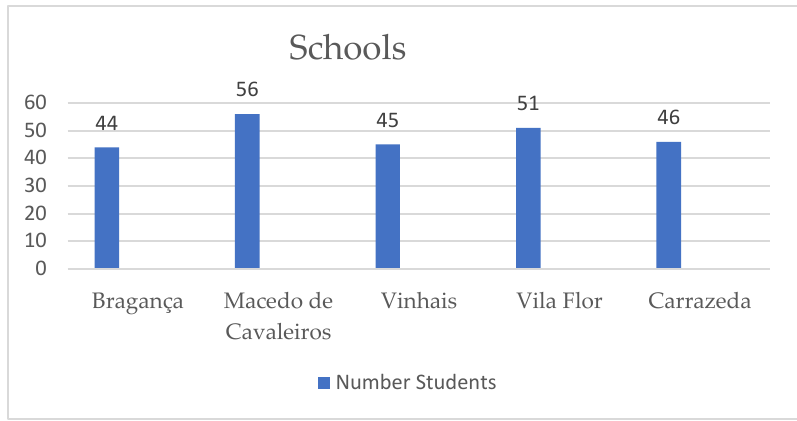
Figure 2. The number of students per school. N = 242.